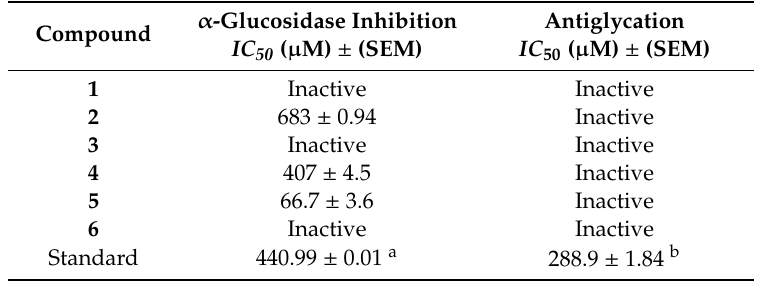
Table 2. α -Glucosidase inhibition and antiglycation activities of compounds 1 – 6